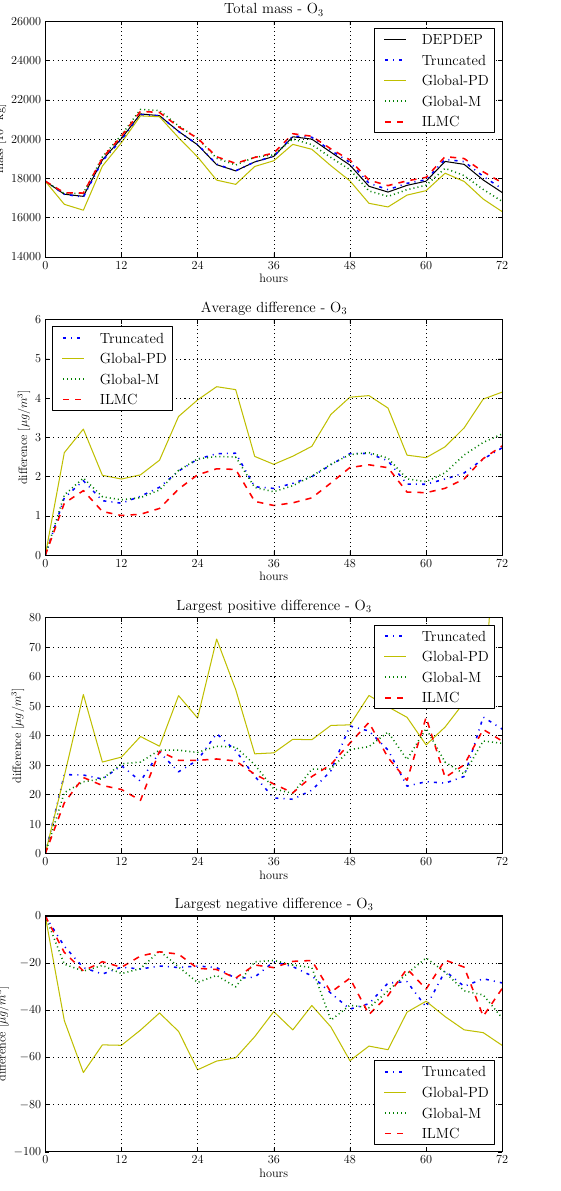
Fig. 9. O 3 (left column) and SO 2 (right column) forecast from 1 July 2009, 00:00 UTC, to 4 July 2009, 00:00 UTC (see Fig. 8). Top row: total mass in the surface layer. Second row: average volume density difference compared to the DEPDEP-filtered solution. Third row: largest positive difference compared to the DEPDEP-filtered solution. Bottom row: largest negative difference compared to the DEPDEP-filtered solution. The lines are as follows: thin solid line (black) is the DEPDEP solution, dot-dashed line (blue) is the truncated SL solution, thick solid line (yellow) is the global positive-definite-filtered solution (Bartnicki), dotted line (green) is the global monotone solution, and the dashed line (red) is the ILMC-filtered